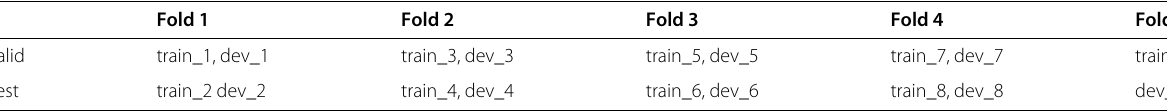
Table 2 RECOLA database 5-fold cross-validation